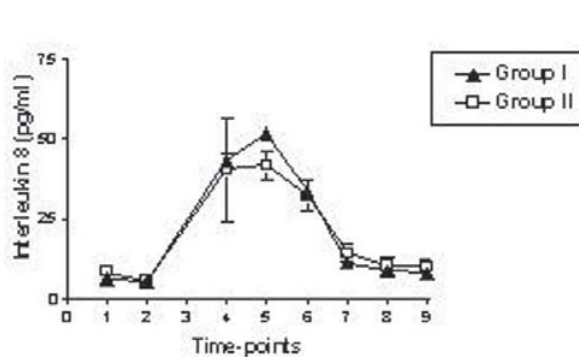
Fig. 4 - Interleukin 6 values over time. Group 1 - no ultrafiltration; Group II - with ultrafiltration. * statistically significant